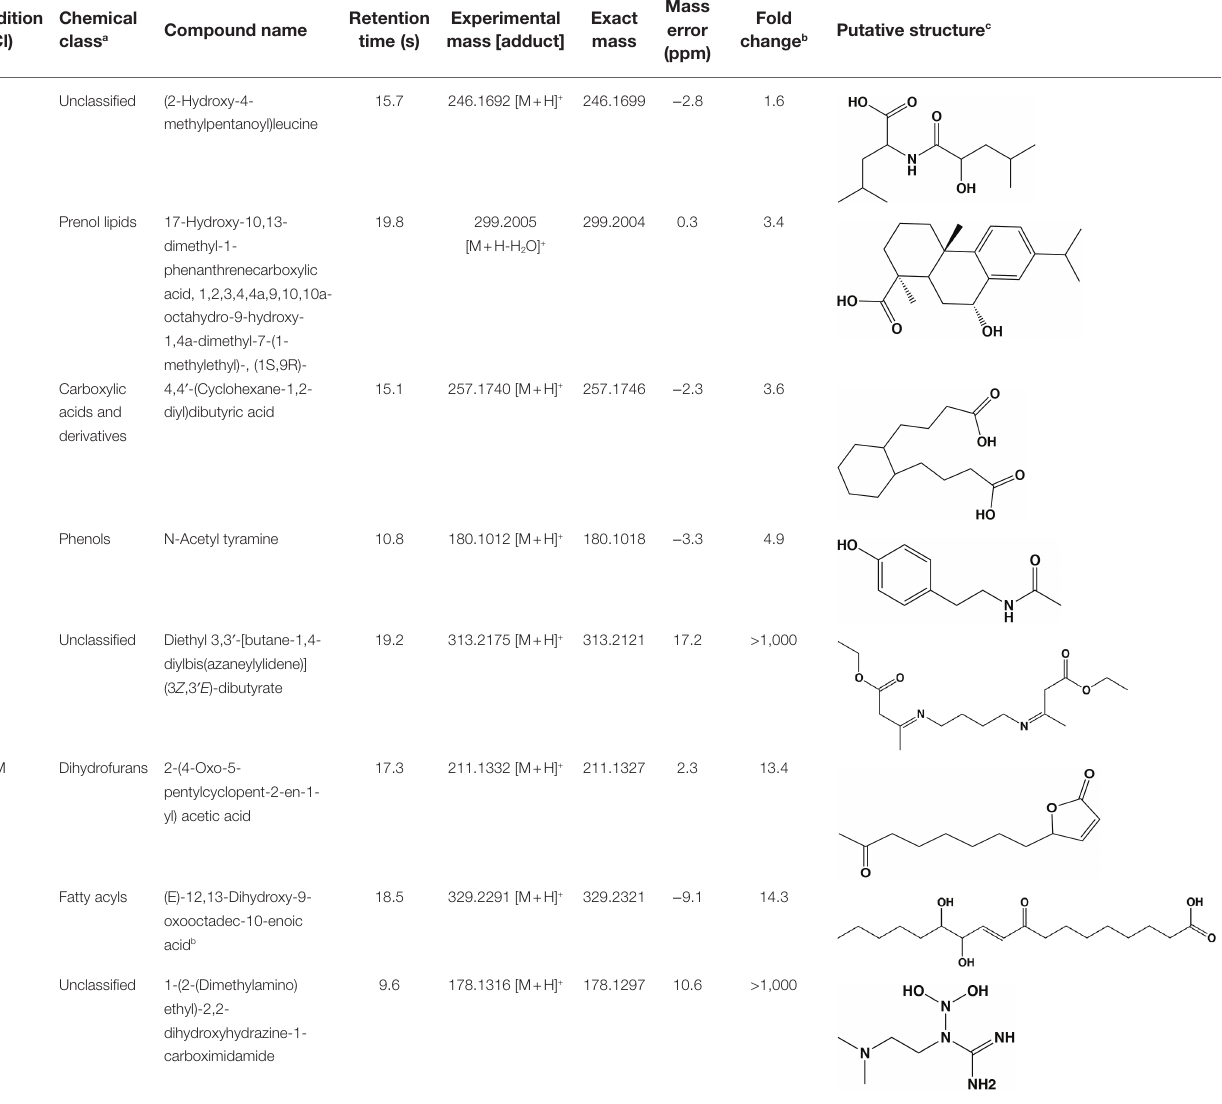
TABLE 2 | List of annotated metabolites denoted by PCVG as metabolic markers in low and high salt conditions. Condition